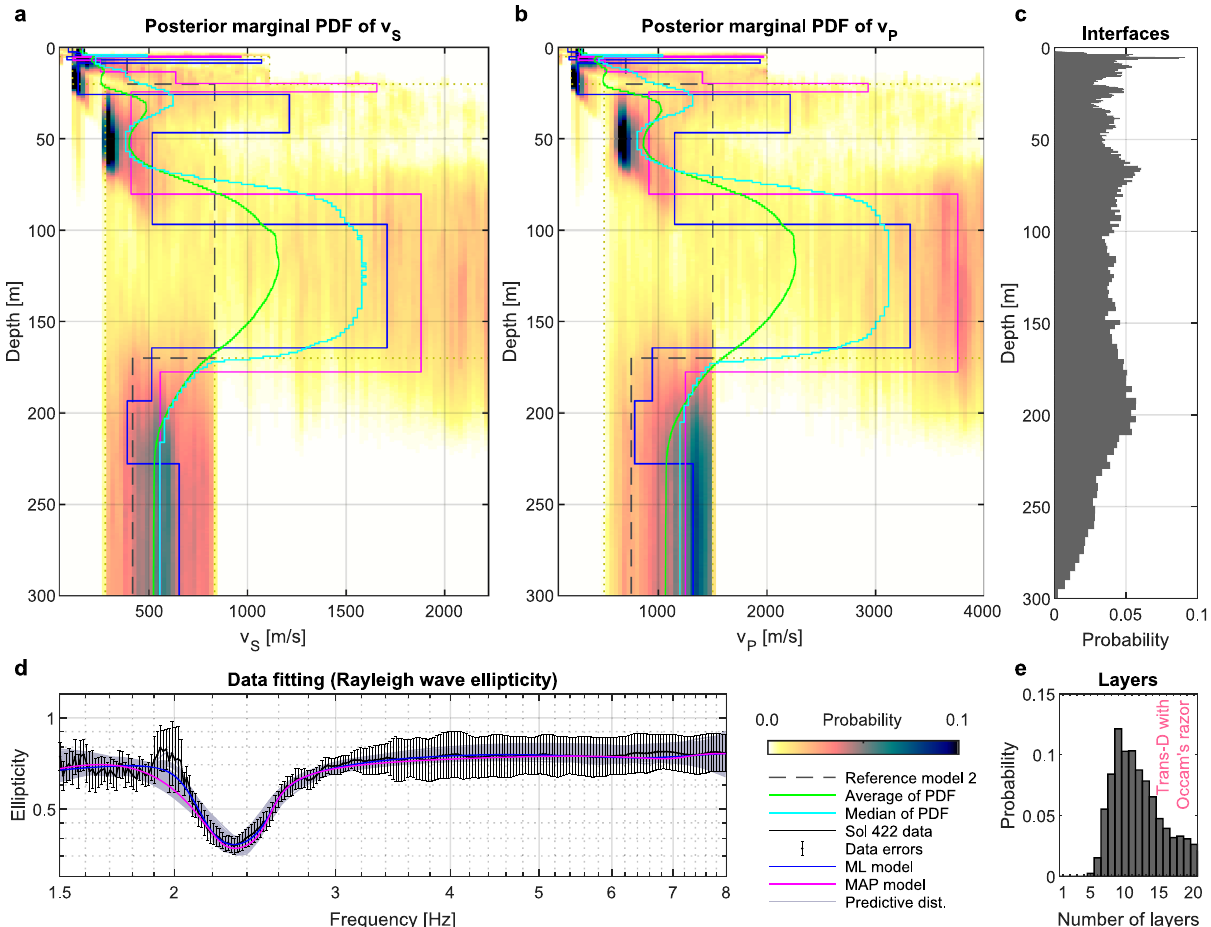
Fig. 6 Result of the Rayleigh wave ellipticity inversion constrained by bounds from model 2. a , b show the posterior marginal probability density functions (PDF) of v S and v P , respectively. c Histogram of the occurrence of layer interfaces. d Extracted (black line) and modeled ellipticity curves (ML maximum likelihood, MAP maximum a posteriori). Vertical bars indicate the expected data error. e Posterior histogram of the number of